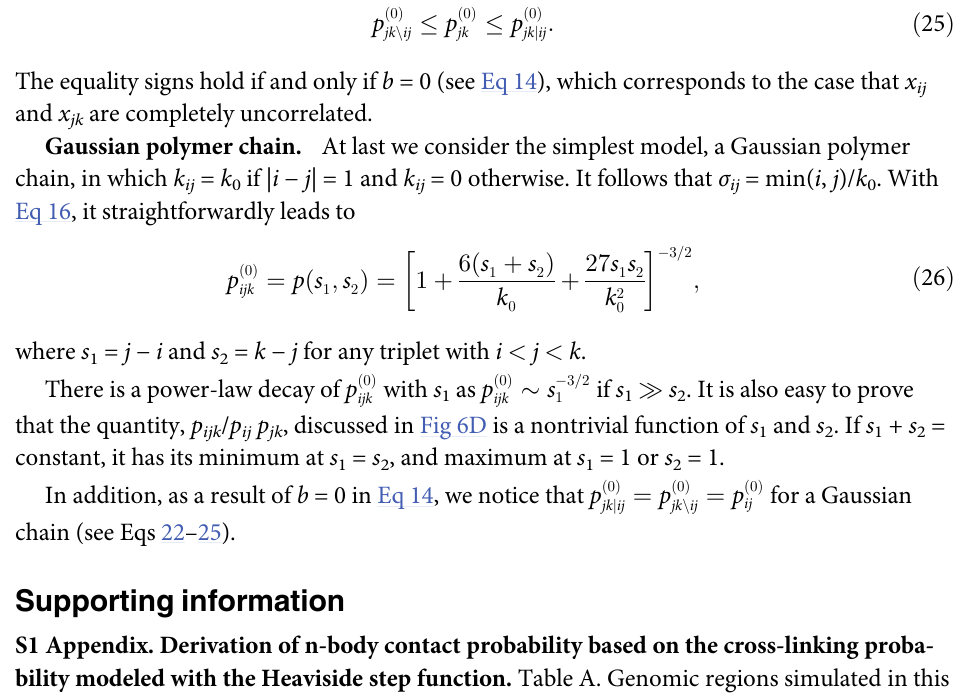
work. Table B. Pearson correlation (PC), stratum-adjusted correlation (SCC8) and distance- corrected Pearson correlation (DCPC9) of the contact probabilities predicted by SBS and HLM compared with Capture-C1 and Tri-C2 experiments. Table C. Stratum adjusted correla- tion (SCC) and PC coefficients between Hi-C and HLM model. S1 Fig. Stratified Pearson correlations of the HLM-predicted contact probabilities. Strati- fied PC at α -globin locus of mouse (A) ES and (B) erythroid cells compared with Capture-C (2-body) and Tri-C (3-body) experiments. S2 Fig. Changes of Tri-C triplet contact frequencies in the α -globin region of mouse ery- throid cells with respect to ES cells. The analysis was done at the viewpoints of R2 (top) and HS-39 (bottom). Following the statistical analysis in the experiment [17], we use the symbol � to mark all triplet interactions with significant changes ( P < 0.01). The erythroid cell-specific regulatory hub and diffuse interactions among CTCF boundary sites, which are highlighted by dashed triangles, are both captured by Tri-C and our theory (Fig 3E). S3 Fig. Analysis of the changes in triplet contacts ( p D WAPL ijk from MC-4C data [18] with respect to the viewpoints of E (top) and K (bottom). The triplet contacts predicted by HLM are shown in Fig 4D. (B) The enrichment of pairwise contacts between long-range CTCF binding sites (off-diagonal elements in red corresponding to short-range CTCF binding sites (matrix elements along the diagonal block in